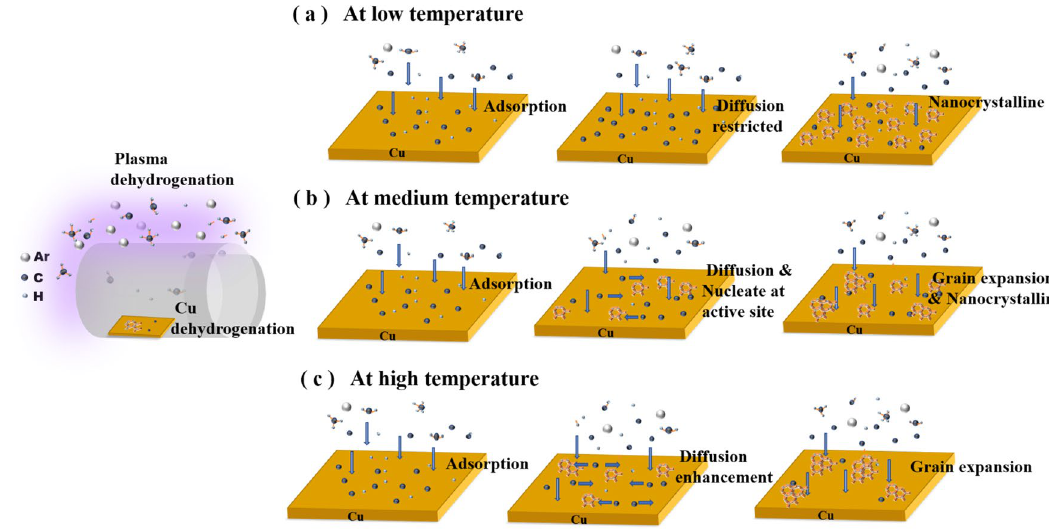
Figure 7. Schematic illustration of the nucleation and growth dynamics of PECVD at different